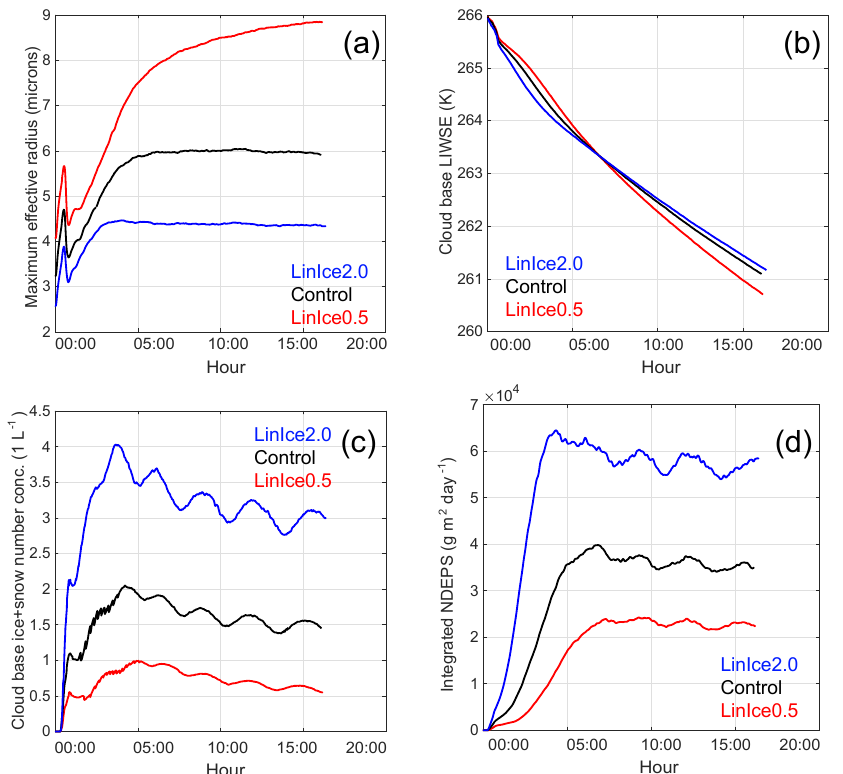
Figure 7. Time series from runs varying CCN concentrations with linear ice formation. (a) Maximum effective radius, in units of microns. (b) Cloud mixed-layer liquid–ice water static energy, in units of K. (c) Cloud base ice plus snow number concentration, in units of L − 1 . (d) Vertically integrated net deposition rate, in units of gm − 2 day − 1 . For CCN and INP factors 0.5 (red), 1.0 (black), and 2.0 (blue).